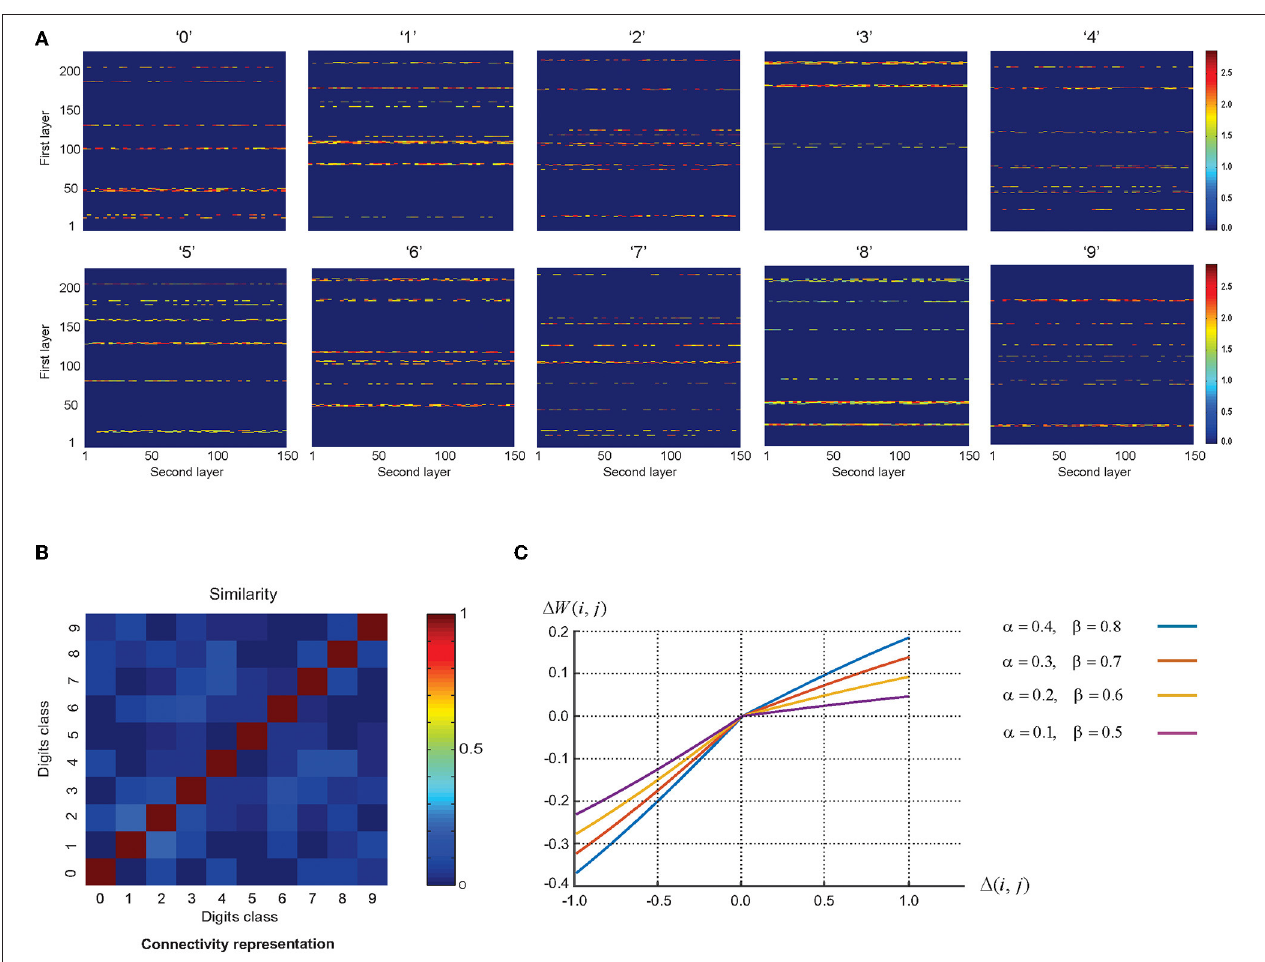
FIGURE 7 | (A) Connectivity matrices of the trained networks for digit classes. Connections and their strengths between the first and second layers are shown. One sample per digit class was used and the number of epochs was set to 12. (B) The similarity of the connectivity matrices after training by image presentation. The results show remarkable discrimination of the representation of images after training. (C) The relation between the change in the synaptic weight of the pairs of neurons ( 1 w ( i , j ) ) and the difference of average firing rate between each pair of neurons in the second layer and the first layer ( 1 ( i , j ) ). Among the values of the learning parameters used in the plot, the pair of α = 0.2, and β = 0.6 results in the highest estimated classification